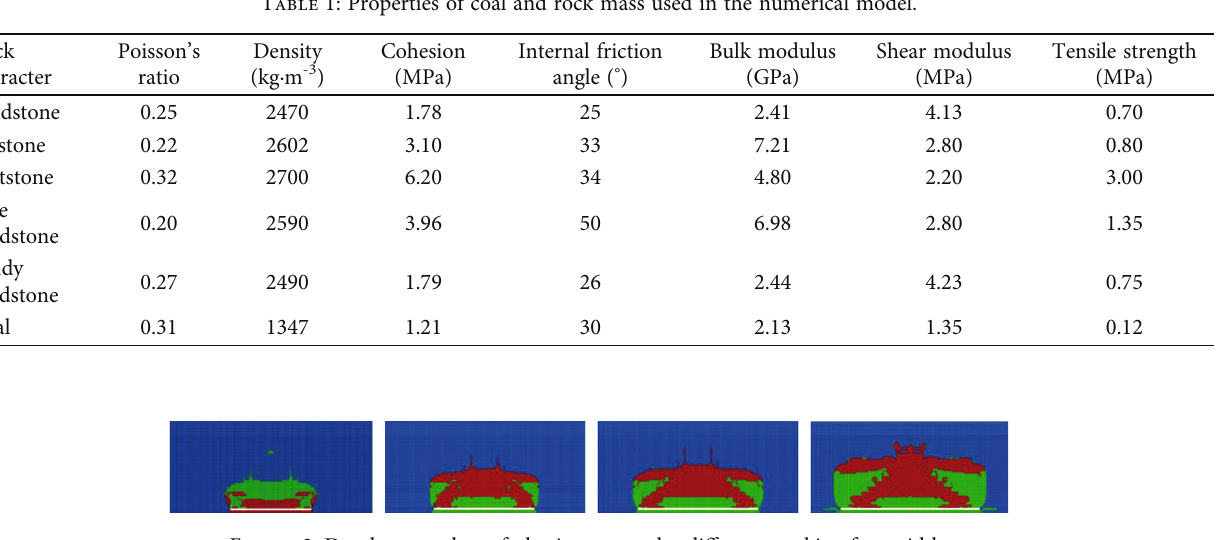
Figure 3: Development law of plastic zone under di ff erent working face